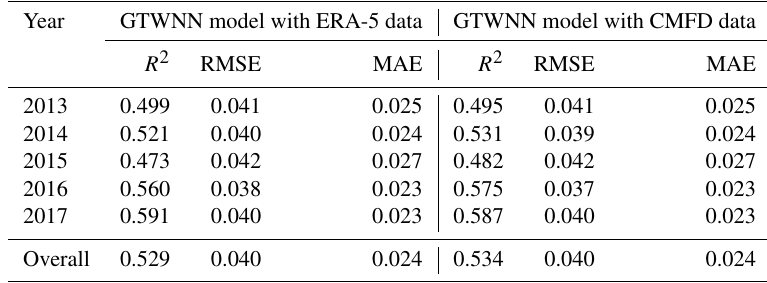
Table 3. Accuracy comparison of estimated snow density with different sources of influencing